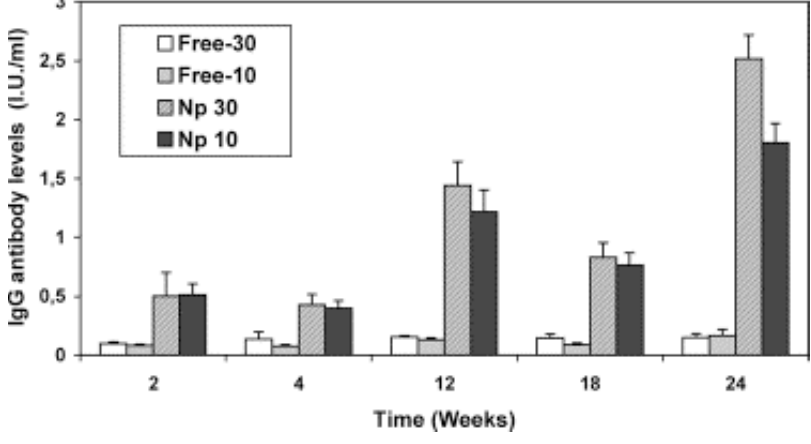
Figure 7. IgG antibody levels after i.n. administration of two doses of antigen (10 and 30 μ g), encapsulated in chitosan nanoparticles (70 kDa) or in solution in mice (geometric mean ± SEM) [reprinted with permission from Ref. [109], copyright Elsevier